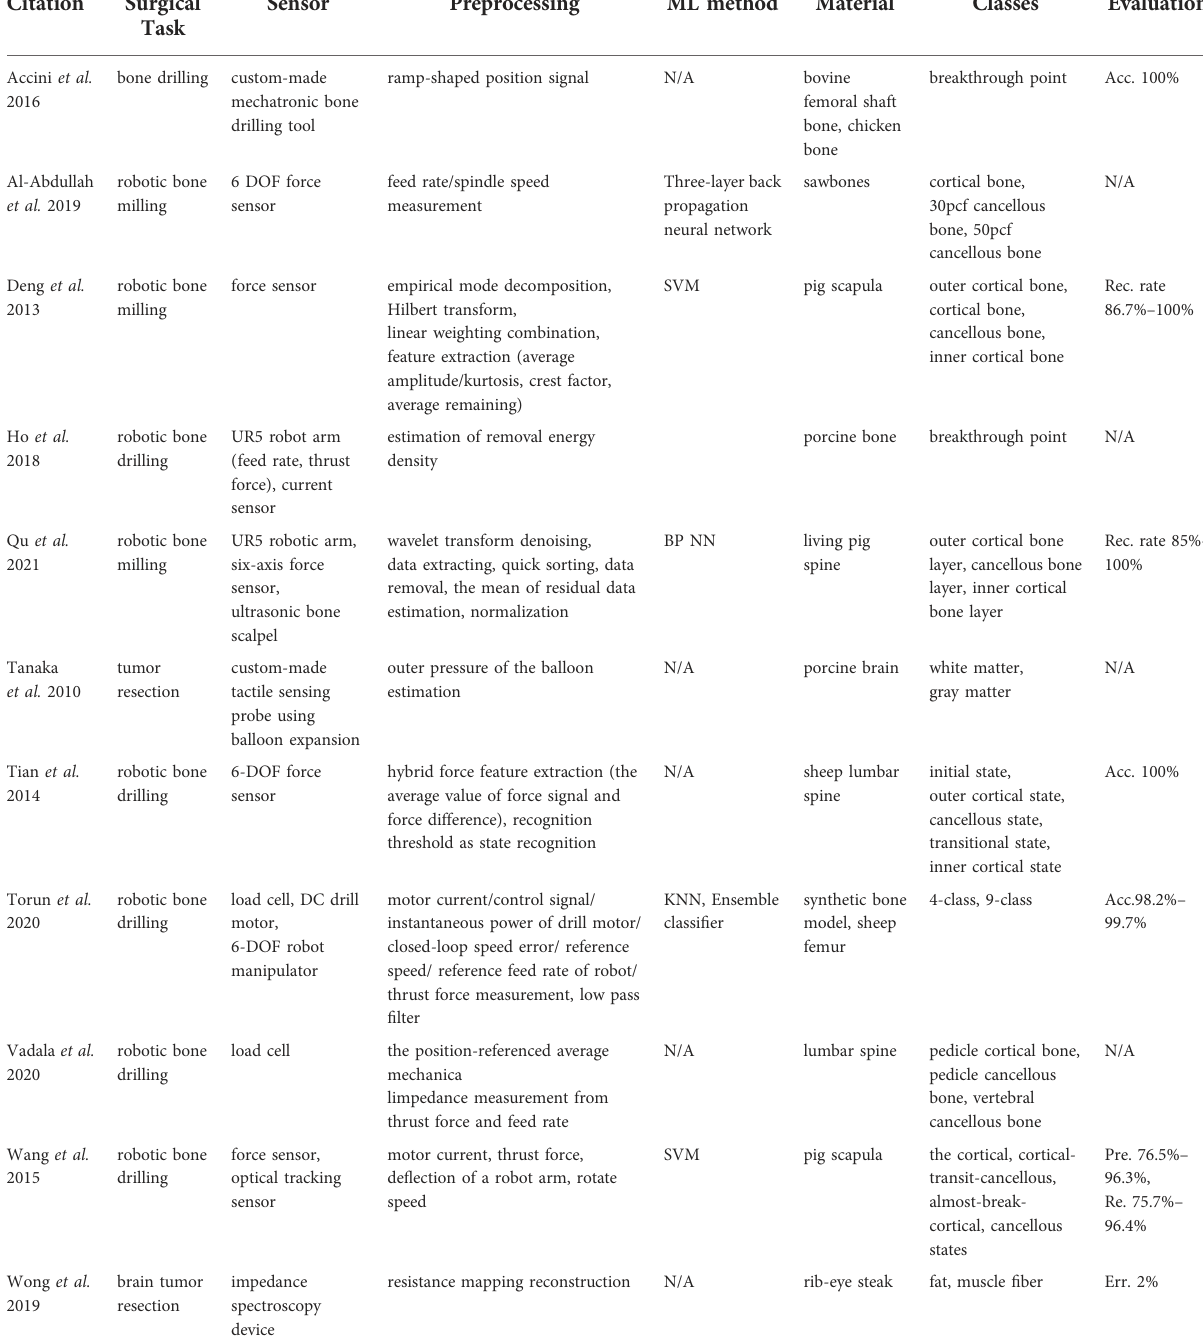
TABLE 5 General description of selected papers related to force, robotic, and impedance